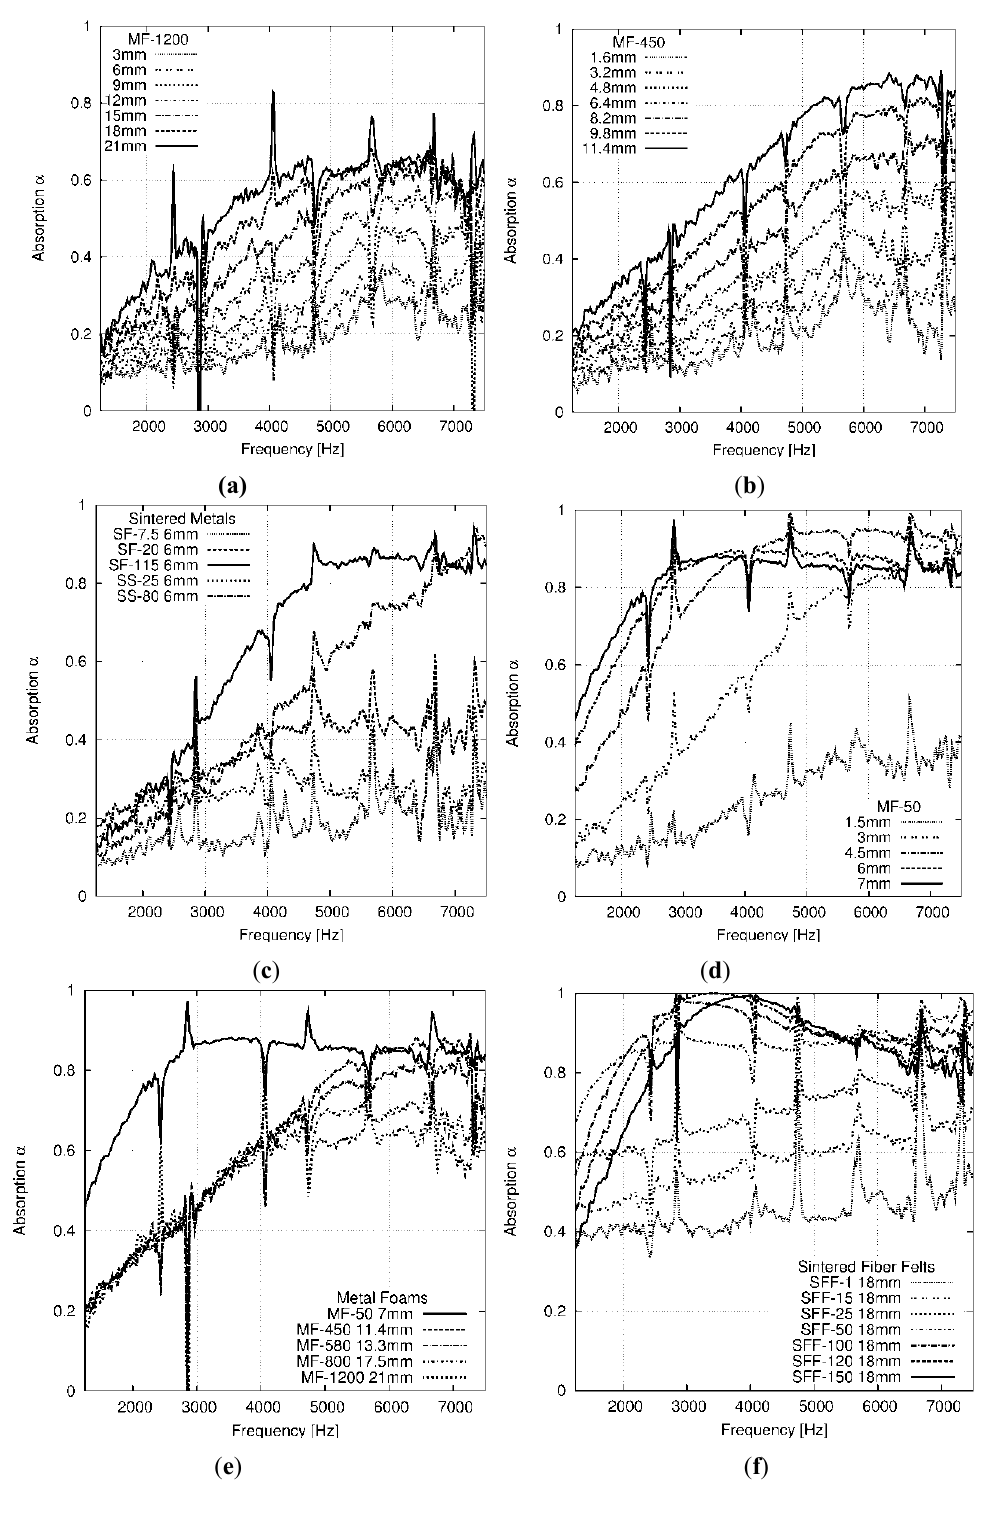
Figure 4. Acoustic absorption of porous materials (detailed description of material properties in Table 1). ( a ) Absorption of MF-1200; ( b ) Absorption of MF-450; ( c ) Absorption of MF-50; ( d ) Absorption of different metal foams; ( e ) Absorption of different sintered metals; ( f ) Absorption of different metal fiber